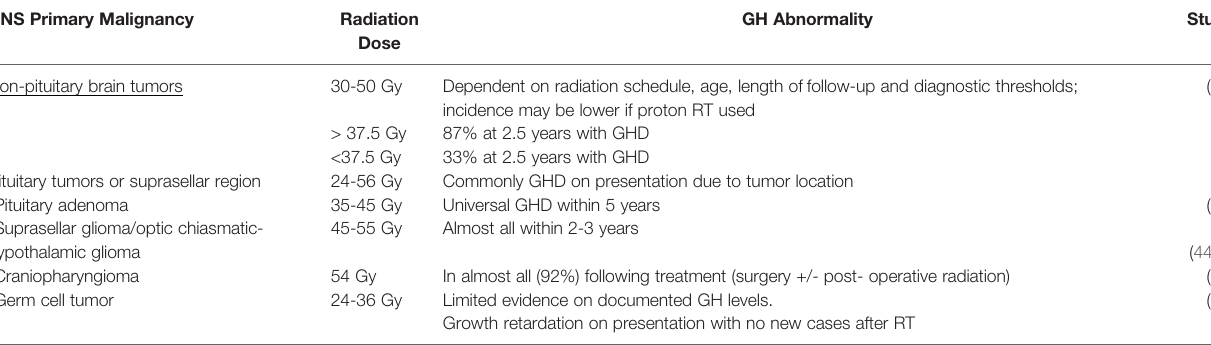
TABLE 1 | Radiation therapy and growth hormone de fi ciency in primary central nervous system tumors.